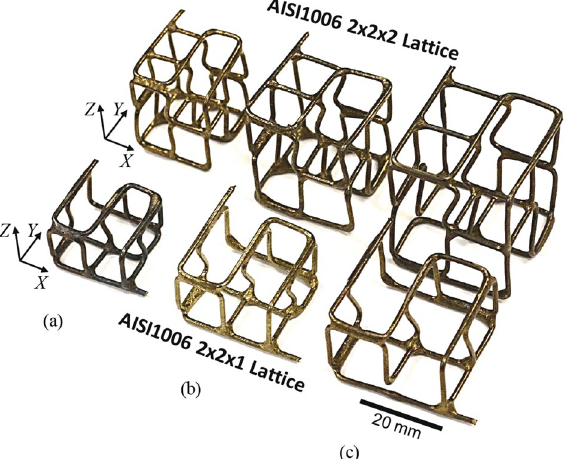
Figure 6. AISI1006 low carbon steel wire lattice structures fabricated and joined for compression testing. The measured relative density ( a ) 8.6% and 6.8% for 8 mm cell; ( b ) 6.4% and 5.3% for 10 mm cell; and ( c ) 5.0% and 3.8% for 12 mm cell with 2 × 2 × 1 and 2 × 2 × 2 structure respectively.